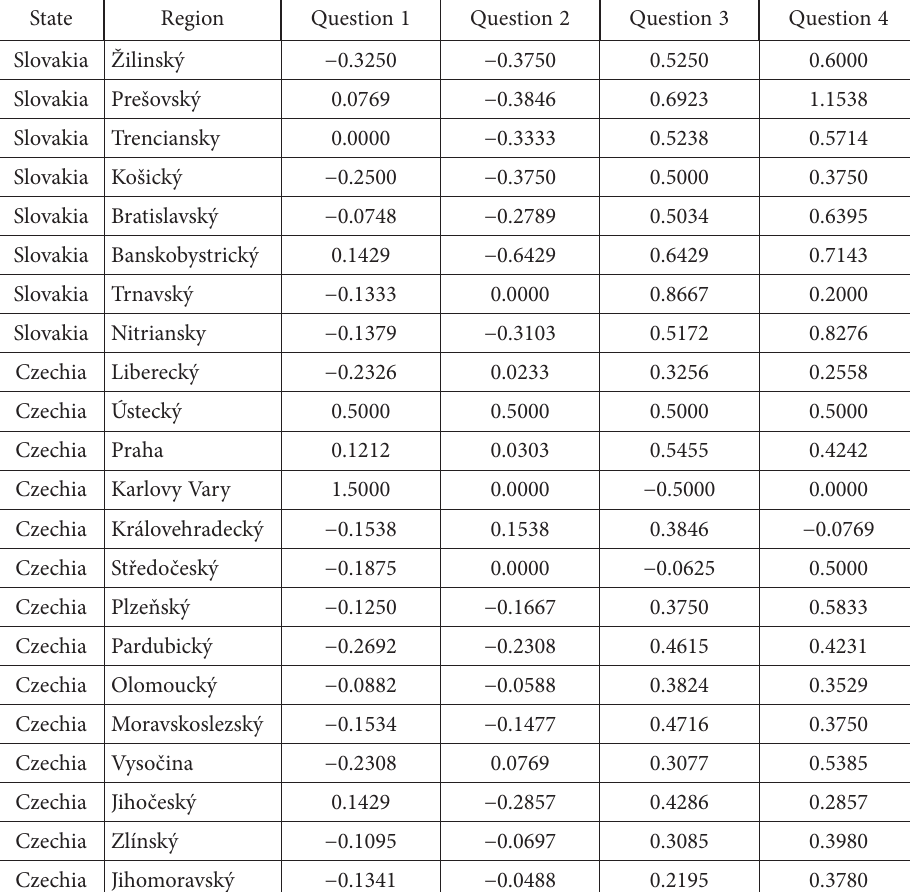
Table 6. Average values of the answers of the respondents from the selected regions (source: own processing)